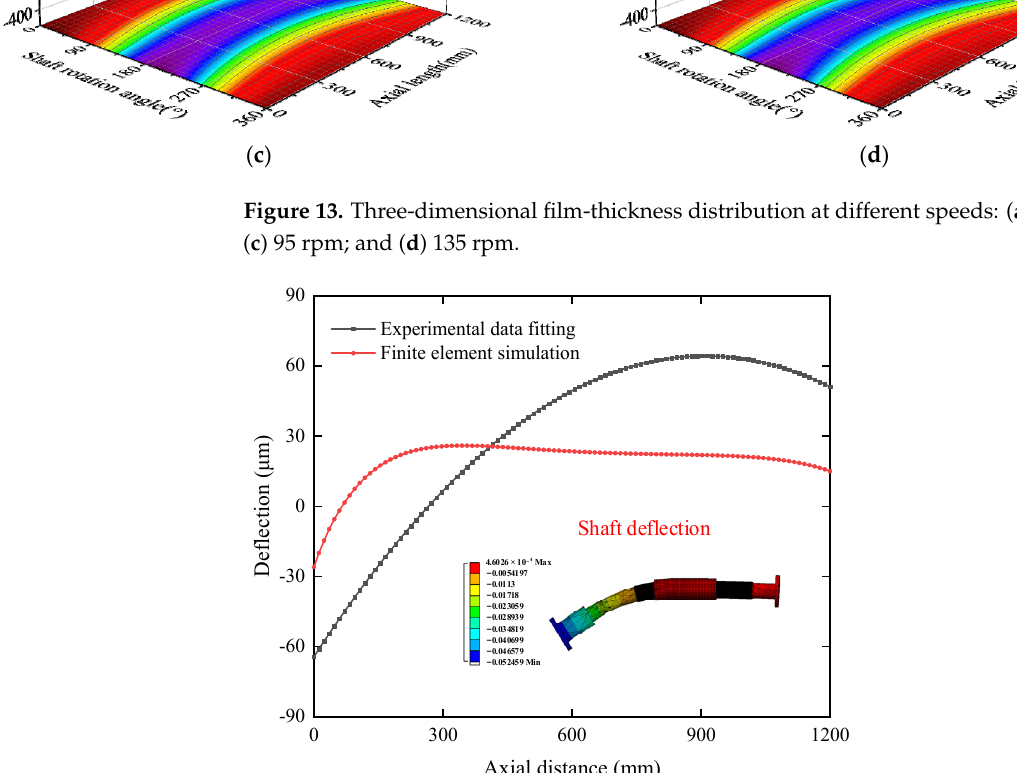
Figure 14. Comparison of shaft ‐ bending curves from FE simulation and least square fitting . Based on the optimized shaft ‐ bending curve, the film thickness of the full bearing is calculated, and the minimum film ‐ thickness distribution along the axial direction at each speed is shown in Figure 15. The three test sections are located at 292 mm, 429.5 mm, and 856 mm, respectively, from the ballast end of the bearing. The minimum film thickness of section D 1 is greater than 6.17 μ m with increased speed to 175 rpm, indicating a change from mixed lubrication state to hydrodynamic lubrication. S ection D 2 changed to hydro ‐ dynamic lubrication after the speed increased to 95 rpm. Section D 3 is in hydrodynamic lubrication at five measured speeds. The above results verify the analysis of the bearing ‐ lubrication status in Figures 9 and 10. As the shaft is deflected by ballast, the ballast section of the bearing is in boundary lubrication and mixed lubrication, and the rest is in hydro ‐ dynamic lubrication. Table 4 shows the range of the three lubrication sub ‐ regions at each speed. It can be seen that during the increase of speed from 35 rpm to 175 rpm, the bound ‐ ary lubrication sub ‐ region is reduced by 56.27%, the mixed lubrication sub ‐ region is re ‐ duced by 18.33%, and the hydrodynamic lubrication sub ‐ lubrication area is expanded by 33.05%. Each lubrication sub ‐ region area varies nonlinearly. 0 D 3 D 2 Figure 15. Minimum film ‐ thickness distribution along the axial direction at each speed.